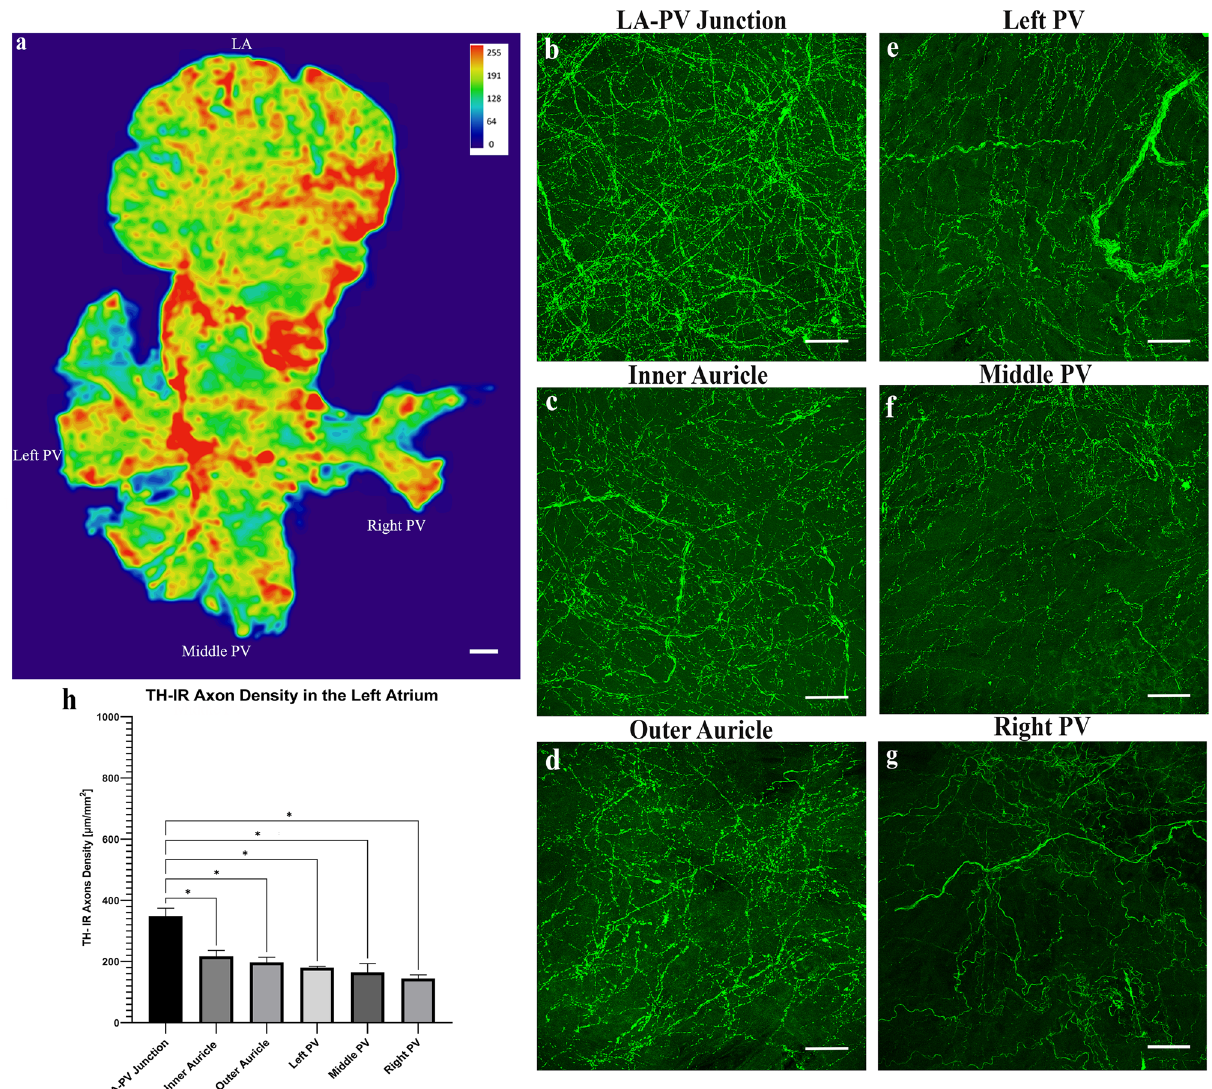
Figure 9. ( a ) Heatmap of the regional density of TH-IR axon innervation in the LA, hot spots are indicated by red color. ( b-g ) Representative images of the regions of interest to show the detailed TH-IR axon innervation in different regions. ( h ) Quantification of TH-IR fibers in LA ROIs of a representative mouse. (Heatmaps were created by Ariege Bizanti with imageJ.1.53t, https:// imagej. net/ softw are/ fiji/). *P < 0.05. n = 6. Scale bars: 500 μm (in ( a )); 50 μm (in ( b-g